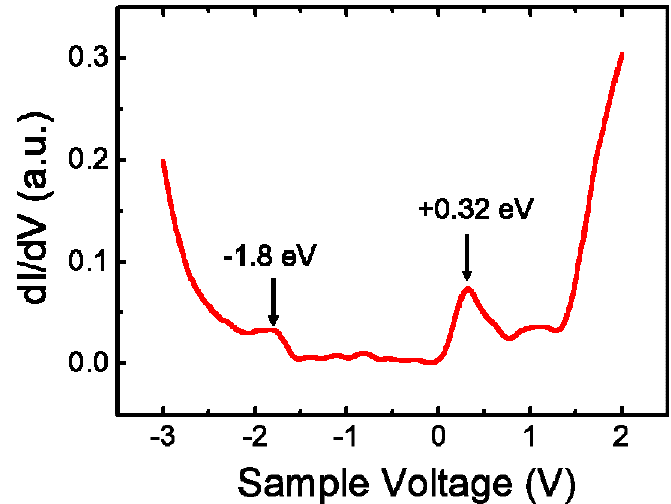
√ √ 3 × 2 3) R30 ◦ domain. The